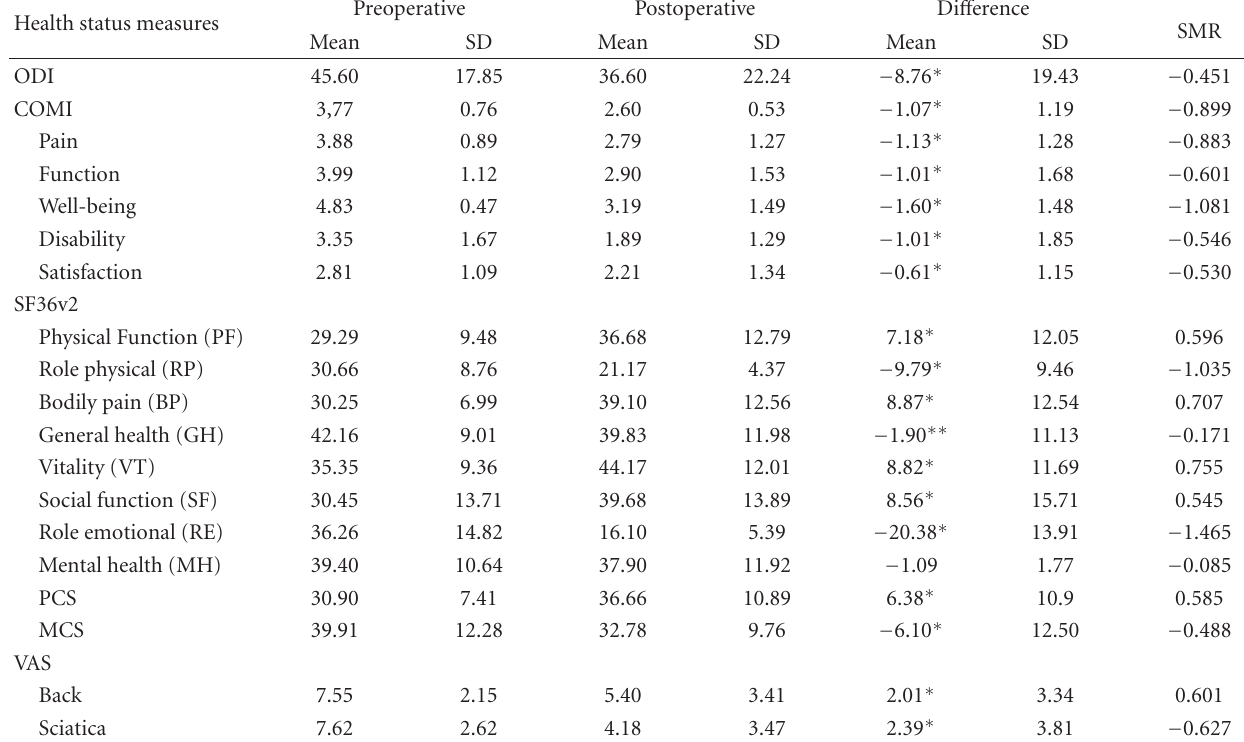
Table 2: Preoperative and 2-year postoperative scores and magnitude of change.